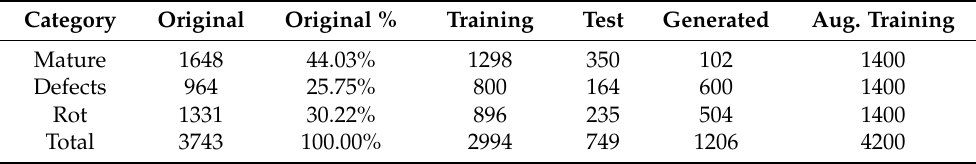
Table 1. The lychee surface defect dataset.